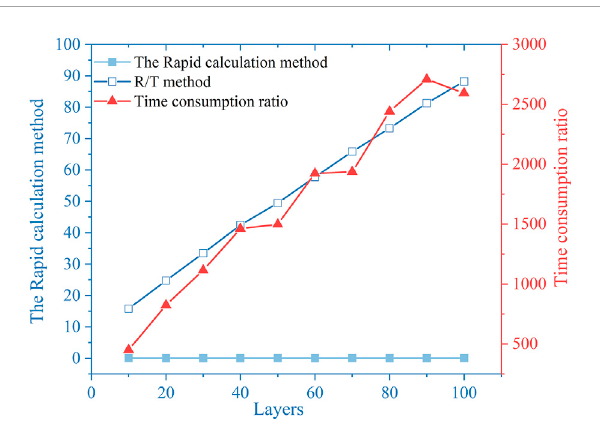
FIGURE 9 Calculating time and time consumption